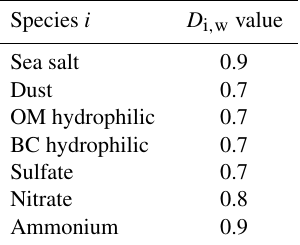
Table 7. Value of the parameter D w , representing the fraction of the aerosol that is embedded in the cloud liquid